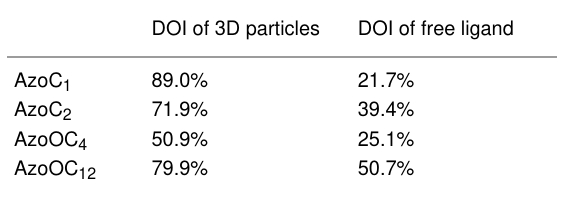
Table 4: DOI for dissolved functionalized 3D particles and free ligands in MeOD. 1 H NMR spectra can be seen in the Supporting Information File 1, Figure